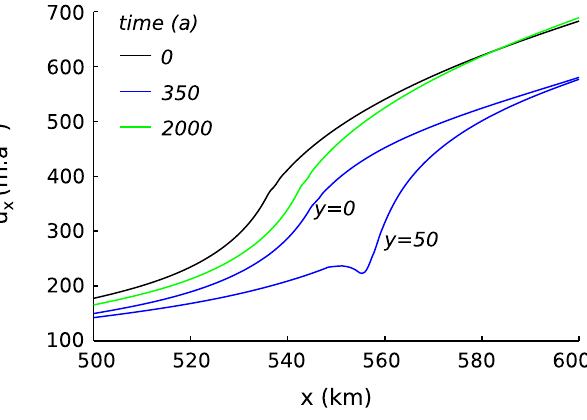
Fig. 6. Vertically averaged velocity in x-direction ¯ u x plotted over x for selected time-levels in the verification experiment, for the two flowlines y = 0 and y = 50 km. Initial steady state (without the pin- ning point) in black, last point in time before removing the pinning point in blue, and final state after 2000 years in green.